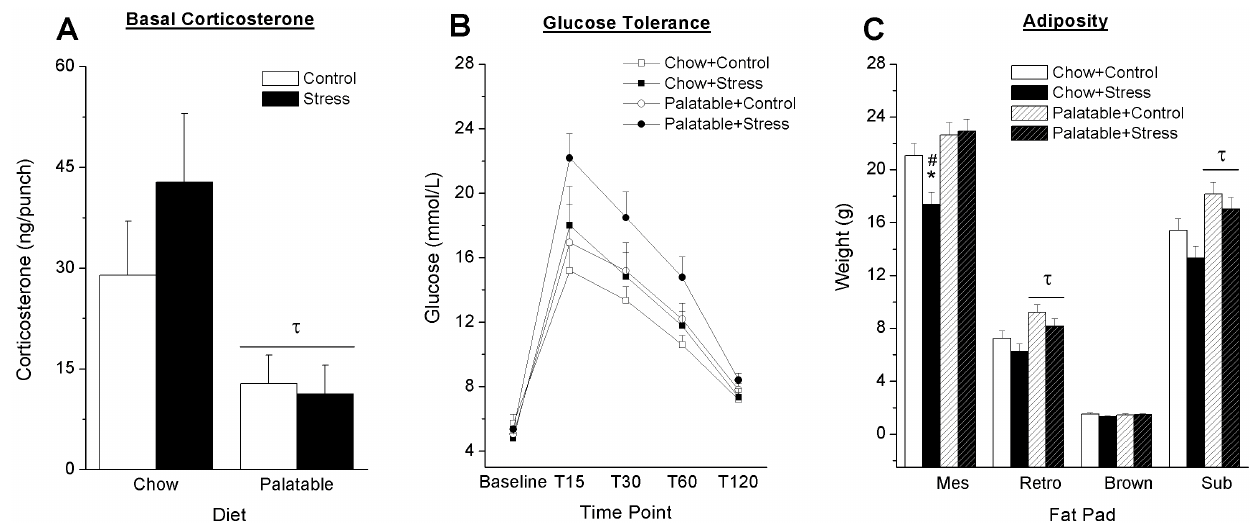
Figure 5. Effect of stress and diet on endocrine and metabolic indices. Rats with access to palatable food displayed lower plasma levels of CORT compared to chow fed rats on PD 66 (A). Blood glucose levels over time following an I.P. injection of a 0.75 g/mL dextrose solution did not differ significantly across groups (B). Rats with access to the palatable diet displayed an increased in retroperitoneal and inguinal subcutaneous fat (C). A decreased weight of the mesenteric fat pad was observed in the Chow + Stress condition relative to their controls and the Palatable + Stress group. Bars represent mean 6 SEM. t Significant diet effect. * Significantly different from controls. # Significantly different from condition matched rats receiving opposite diet. Mes = Mesenteric fat pad. Retro = retroperitoneal fat pad. Brown = Inter-scapular brown fat. Sub = Subcutaneous inguinal white fat pad.